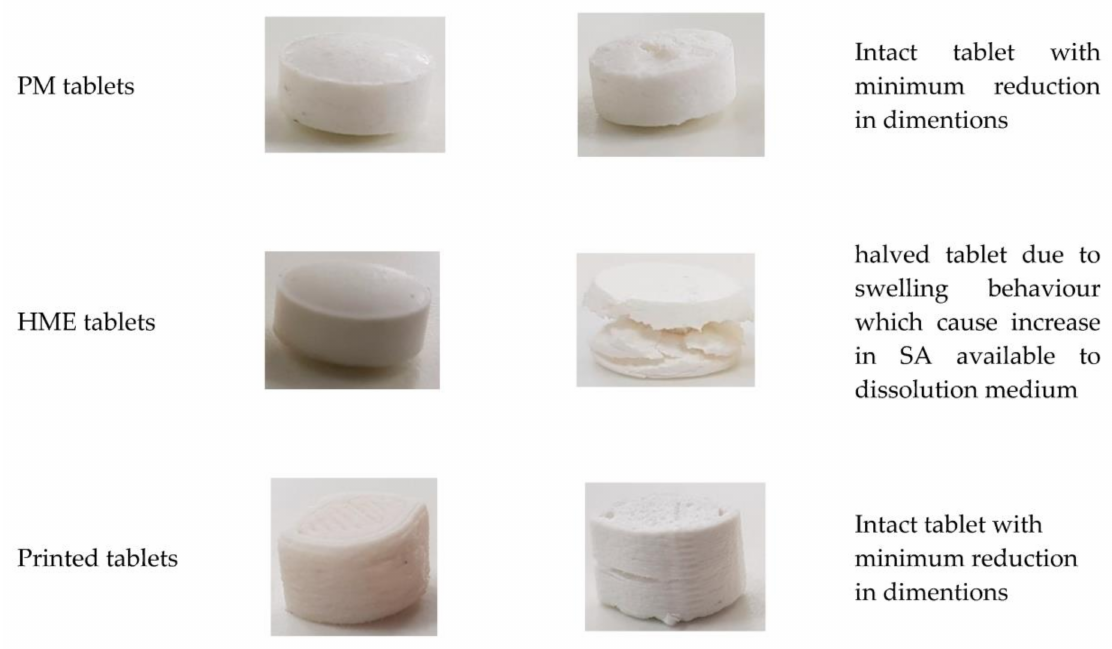
Figure 6. Visual changes to the shape of tablets (F2) after and before dissolution